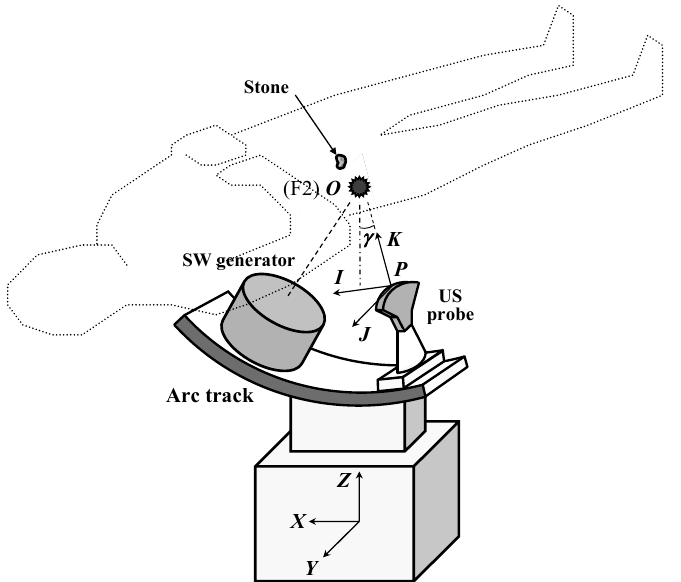
Figure 5. The coordinate system of the US probe for stone